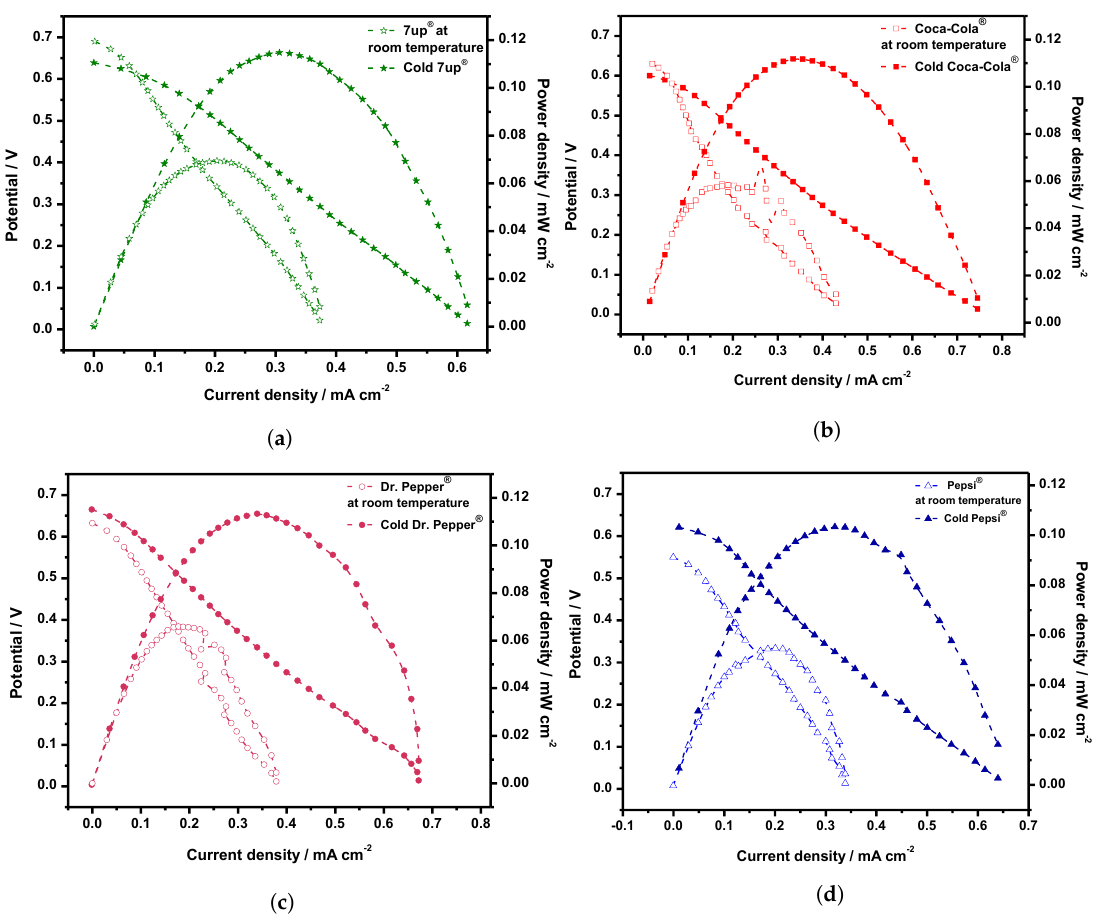
Figure 6. Polarization and power density curves of PtRu/C and Pt/C as anode and cathode, respectively that uses real soft drink cold (solid Figures) and soft drink at room temperature (open Figures) as fuel and air as oxidant. ( a ) 7up R